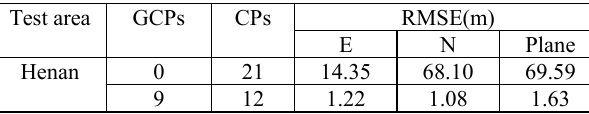
Table 1. Accuracy of stitching with and without GCPs